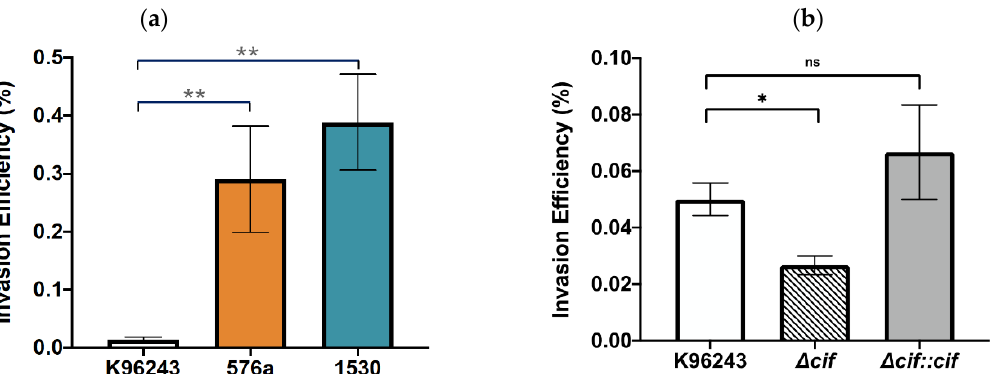
Figure 2. Invasion efficiency of B. pseudomallei strains into SH-SY5Y cells. B. pseudomallei strains in- fected SH-SY5Y cells at an MOI of 20. At 2 h post-infection, the invading bacteria were harvested and plated on culture plates for enumeration. Values are shown as the mean ± SEM of three inde- pendent experiments. ns: not significant, * p < 0.05, ** p < 0.01. ( a ) Invasion of B. pseudomallei K96243, 576a, and 1530. ( b ) Invasion of B. pseudomallei K96243, cif -deleted mutant ( Δ cif ), and complemented cif mutant strain ( Δ cif::cif ).